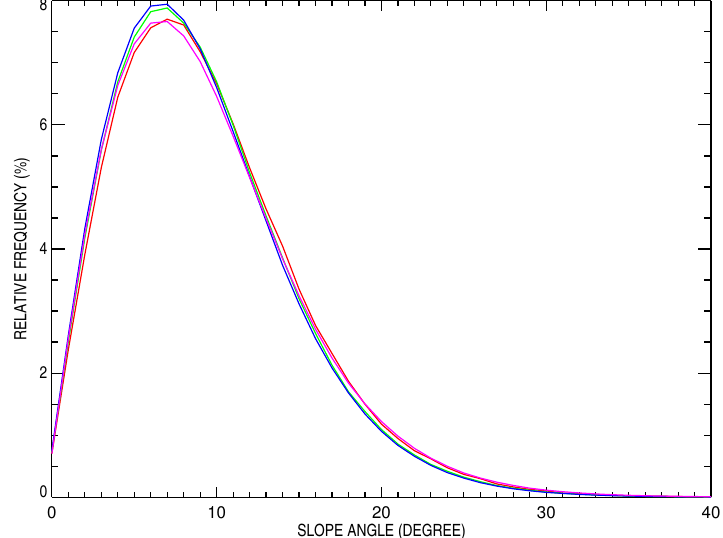
Figure 3. Slope angle relative frequency distribution over the four ROIs: 10 km × 10 km (red line), 20 km × 20 km (green line), 50 km × 50 km (blue line) and 100 km × 100 km (magenta line). Horizontal surfaces have a 0 ◦ normal